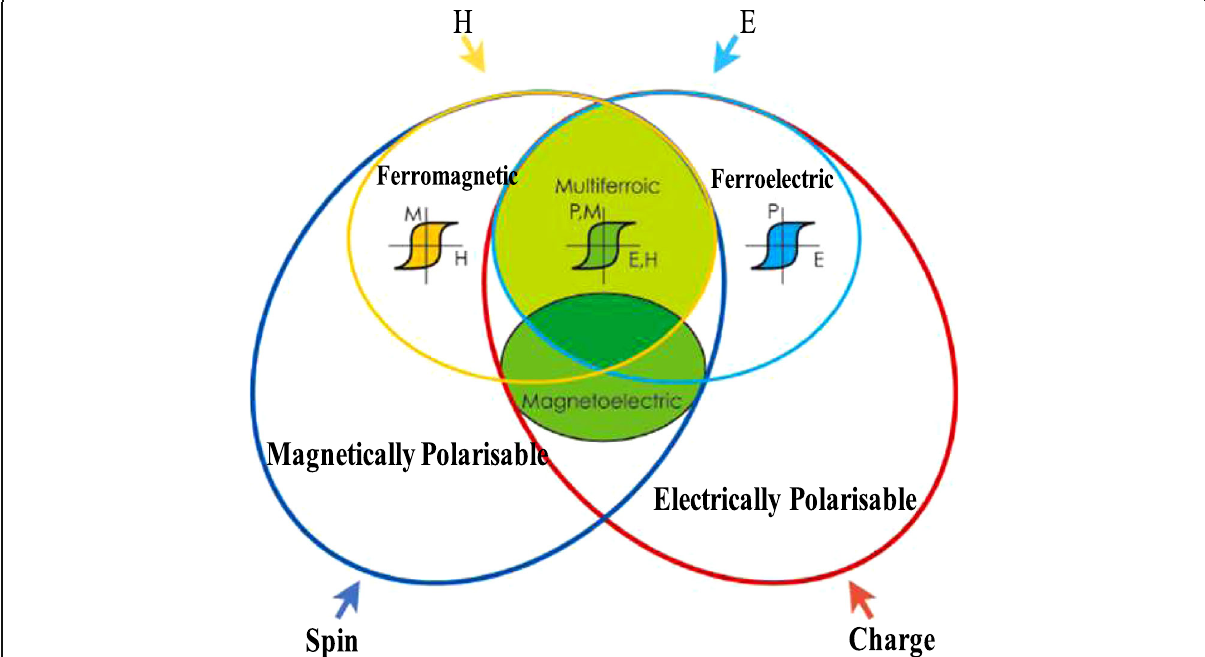
Fig. 3 General classification of multiferroic materials. Adapted from Eerenstein et al.